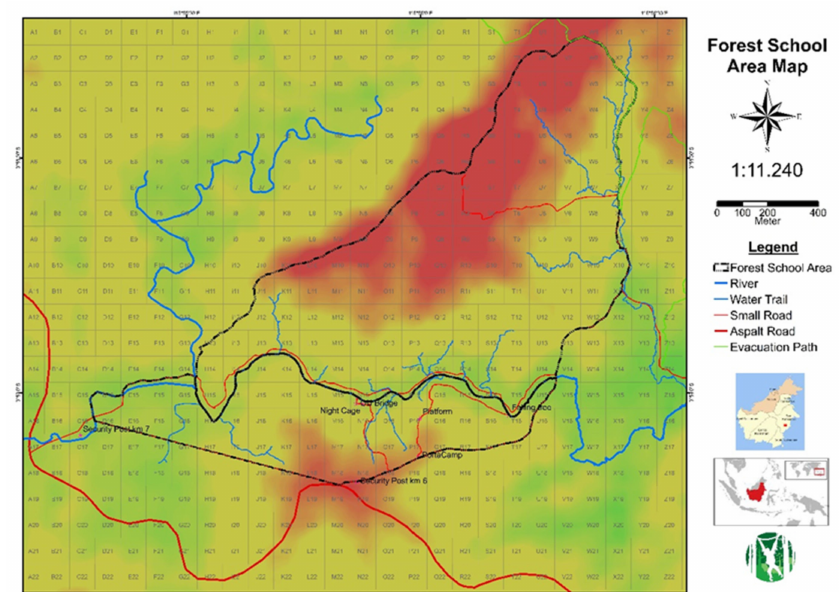
Figure 1. Topographic map of the Forest School (outlined in black) with locations of supporting struc- tures Portacamp (for young orphans) and Post Sungai (for older orphans) south of river Sakakanan, and the quadrants enabling easy communication about current location of orangutans and people. Quadrants are 100 × 100 m in